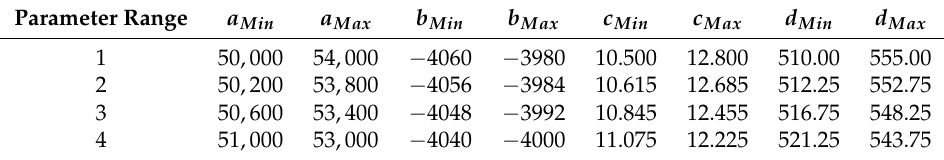
Table A2. Defined material parameter